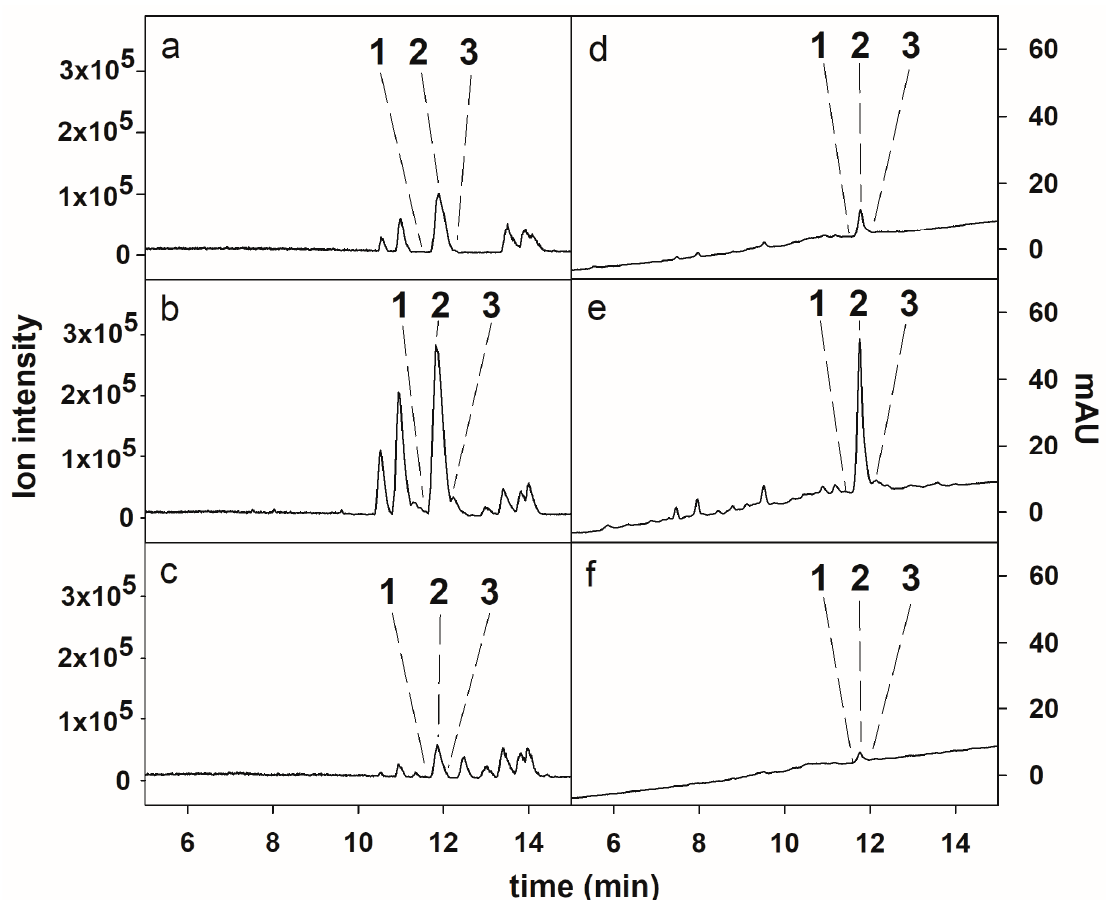
Figure 1. ESI-HRMS base peak ( a – c ) and UV ( d – f ) chromatograms of the crude extract from D. muscorum CCALA125 ( a , d ), the muscotoxin-enriched extract obtained by consecutive treatment on Amberlite XAD-16 ( b , e ) and Amberlite XAD-7 ( c , f ) adsorption resins. The UV chromatograms were monitored at 240